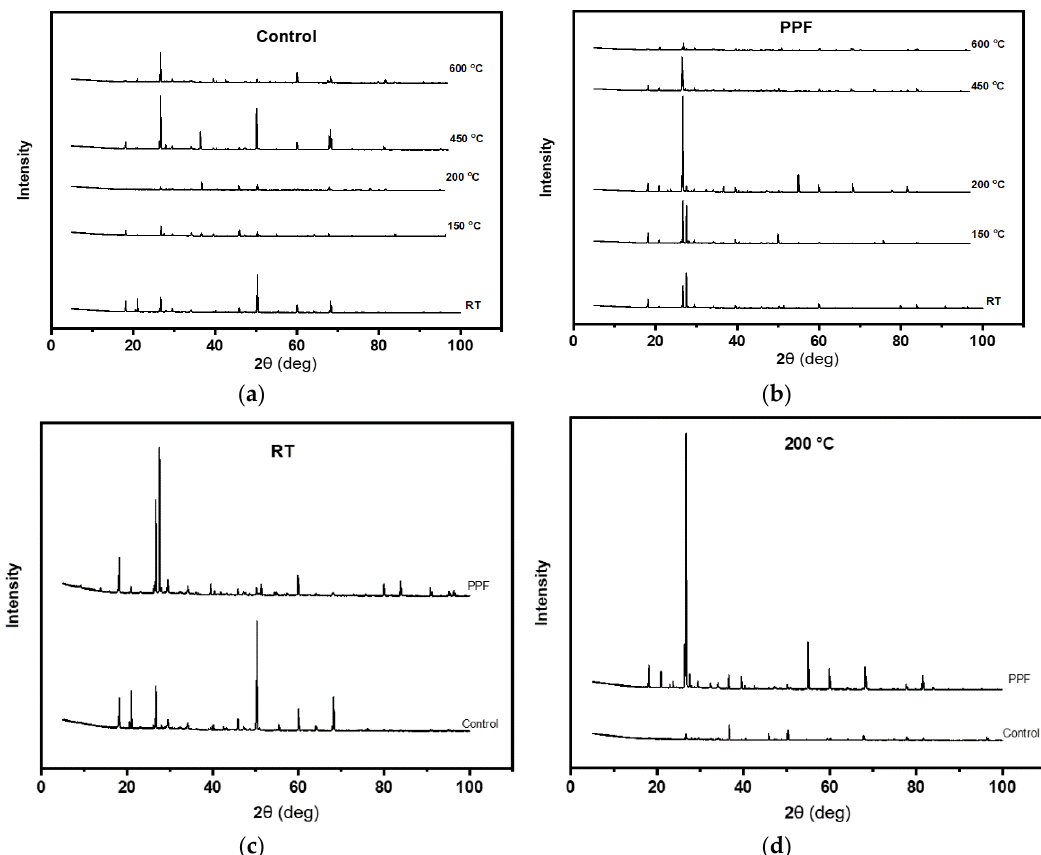
Figure 12. X-ray diffraction (XRD) patterns for ( a ) plain and ( b ) fiber-reinforced specimens heated at various temperatures and XRD patterns comparison ( c ) at room temperature and ( d ) at 200 °C.